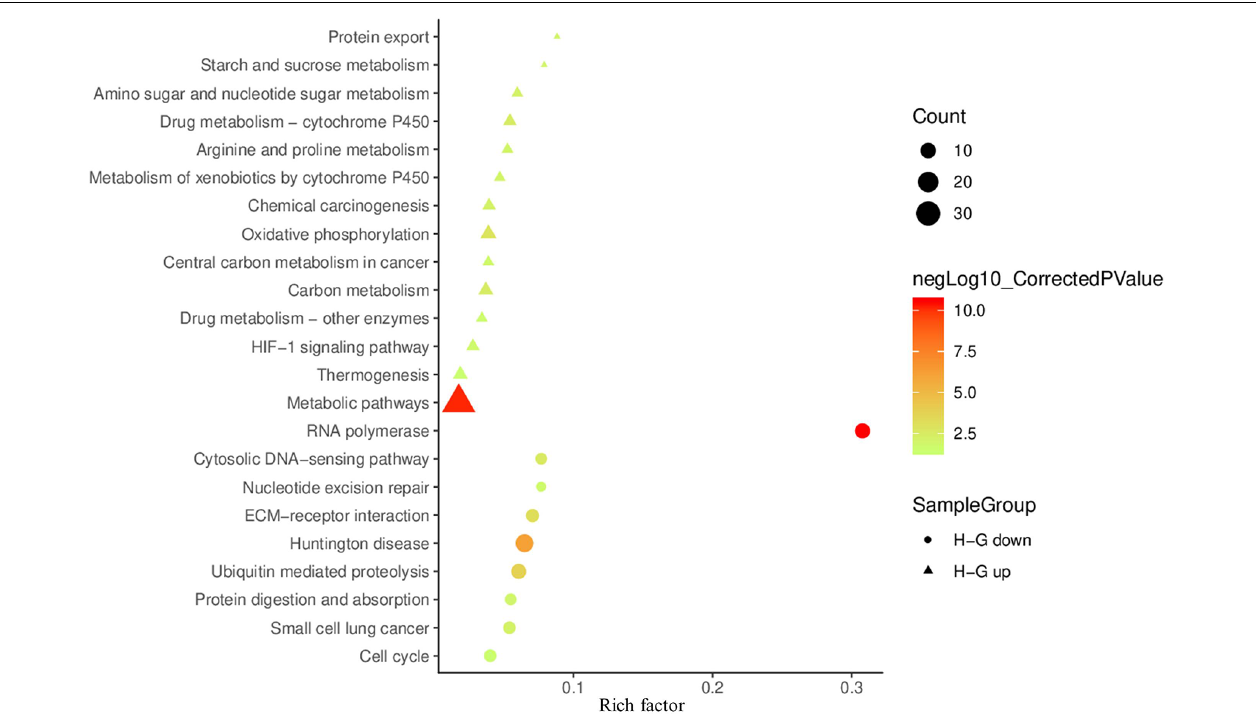
FIGURE 6 | Scatter plot of KEGG enrichment results of DAPs between H − G and N+G treatments. The up-regulated and down-regulated enrichment pathways are shown in the bubble chart with more than three genes enriched and the corrected p < 0.05. The rich factor is the number ratio of annotated DAPs compared to all annotated genes in the same pathway. The larger value means the greater degree of pathway enrichment. The colors of the circles (down) or triangles (up) represent in the − log 10 ranges (corrected p -value) where the higher value indicates greater pathway